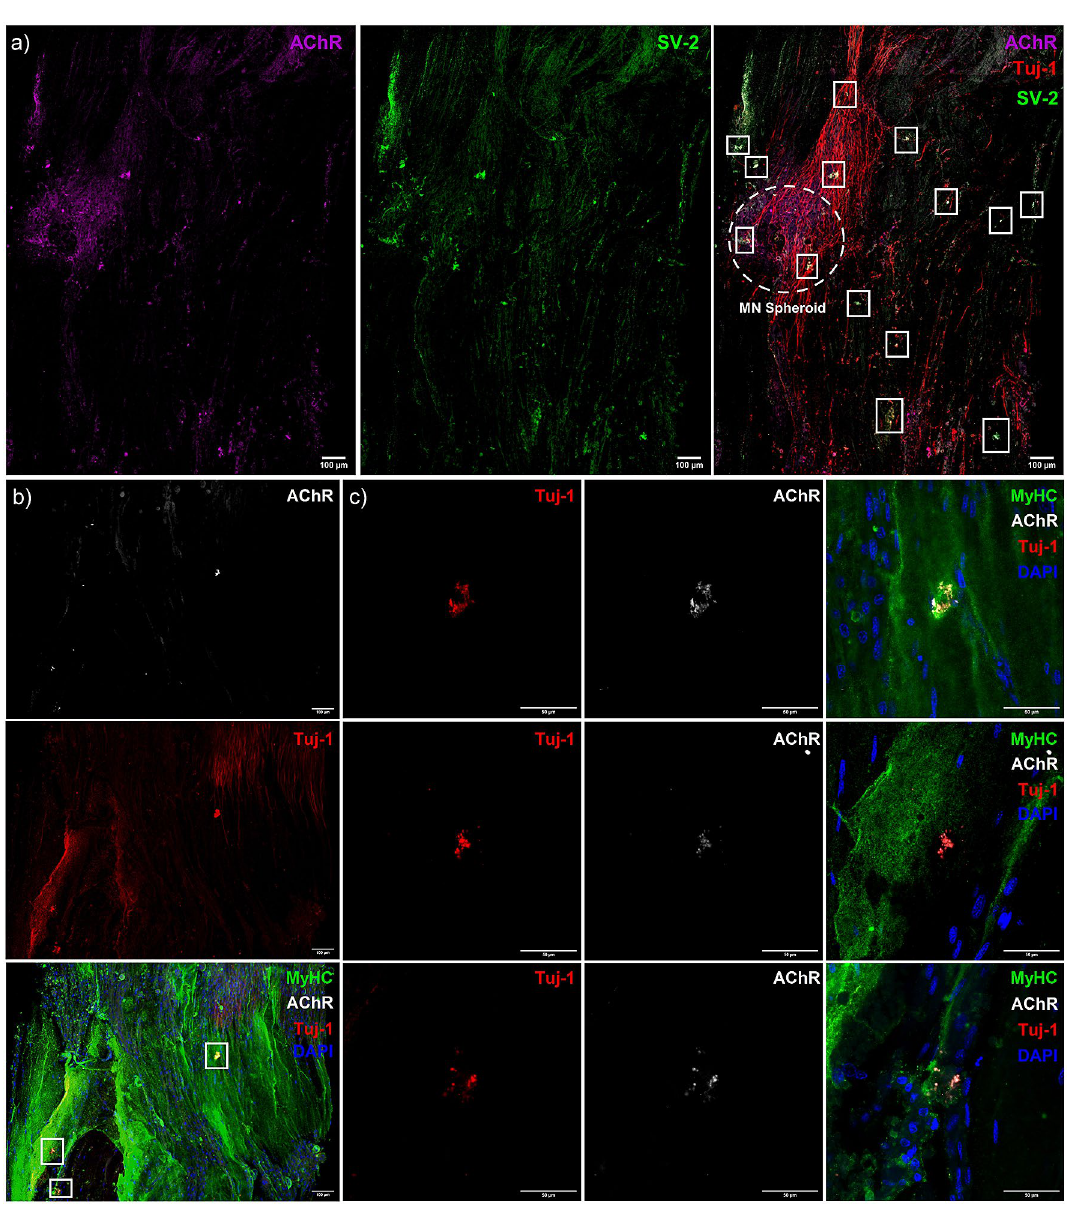
Figure 6. Co-localisation of pre- and post-synaptic membrane proteins, motor nerve axons and myosin heavy chain positive fibres indicate neuromuscular junction formation in engineered tissues. ( a ) Confocal tile scan of neuromuscular tissue detailing AChR (left) and SV-2 (middle), with overlay (right) evidencing multiple synaptic contacts (outlined—white boxes) via co-localisation of pre- and post-synaptic markers and Tuj-1 + neuronal axons. ( b ) Confocal tile scan of neuromuscular tissues evidencing AChR, Tuj-1 + nerve terminal and myosin heavy chain co-localisation. ( c ) Zoom of synaptic contacts highlighted in ( b ) via white box outline. Images were collected across n = 8 neuromuscular tissues. Scale bars = ( a , b ) 100 µm, ( c ) 50 (Fig. 2). Maximal axon extension was observed after 14 days spheroid culture, aligning with mRNA expression data. Transcription of OLIG2 and ISLET1 increased linearly until day 14 before reducing significantly by day 21, with only mature marker SMI32 further enhancing transcription at this time-point. This suggests that spheroids matured in suspension, as used in this work, require adherent surfaces prior to this point for optimal neurite growth. Differences in axon projections of neuronal stem cell and progenitor spheroids have been observed previ- ously, with maximal axon lengths of < 400 µm being enhanced to ~ 800 µm following vascular integration 36 . Axon lengths of ~ 700 µm have also been evidenced in spheroids devoid of vasculature in 3D microfluidic devices 28 . Importantly, this methodology to produce 3D spheroids results in axons, at 14 days, of 1000–1600 µm length of which 90% are SMI-32+ (Fig. 2) in the absence of vasculature. In vivo the spinal motor neuron soma resides within a 3D environment of grey matter within the ventral horn, extending axons to the peripheral musculature. In an attempt to replicate this environment, different